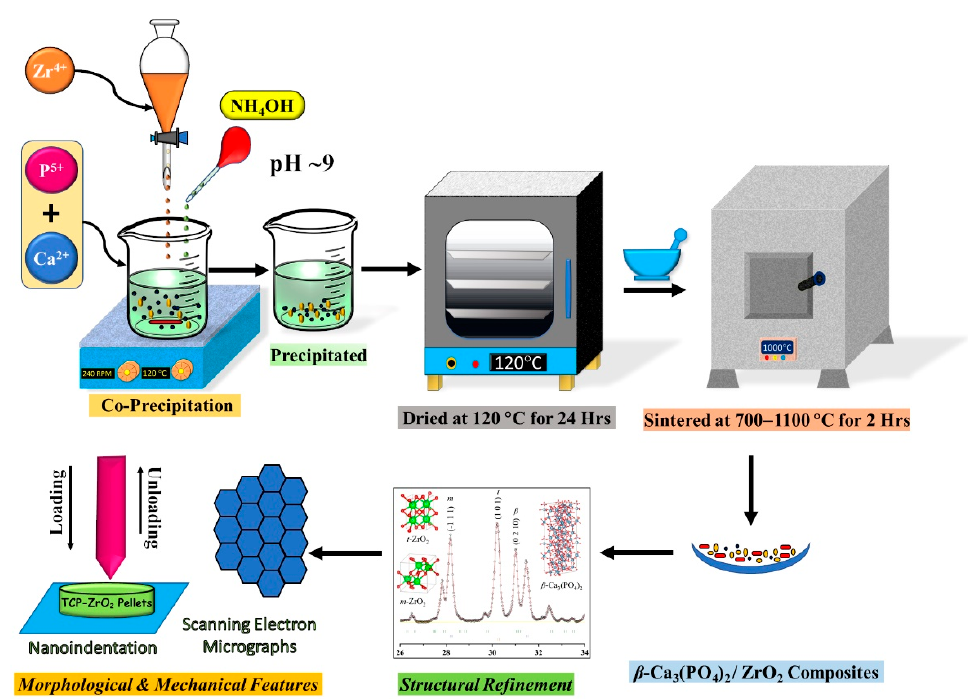
Figure 1. Schematic illustration of the synthesis and fabrication of the β -Ca 3 (PO 4 ) 2 –ZrO 2 compo- sites.